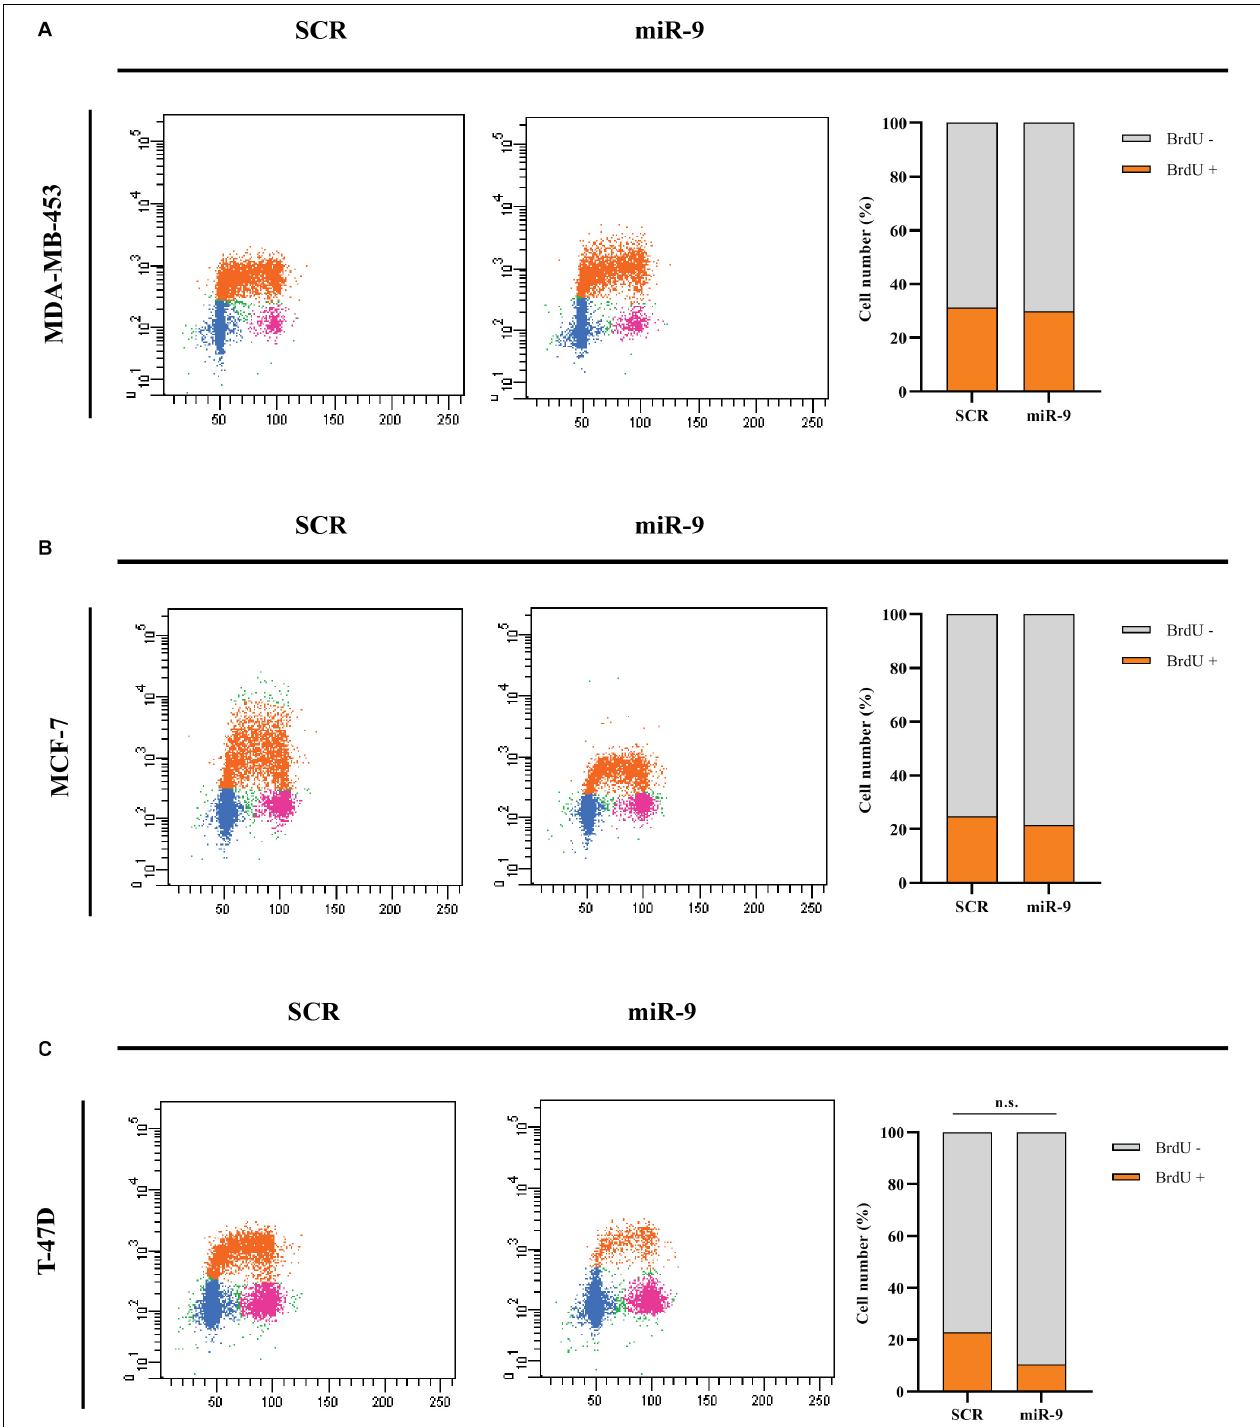
FIGURE 3 | Cytofluorimetric evaluation of the effects of miR-9-5p (miR-9) on DNA replication at 72 h post-transfection. Cytofluorimetric dot plots of proliferating MDA-MB-453 (A) , MCF-7 (B) , and T-47D (C) BC cell lines, following BrdU incorporation, and anti-BrdU antibody incubation. The percentage of cells in S phase, which results in BrdU positive cells (BrdU+) was presented in the histograms on the right.